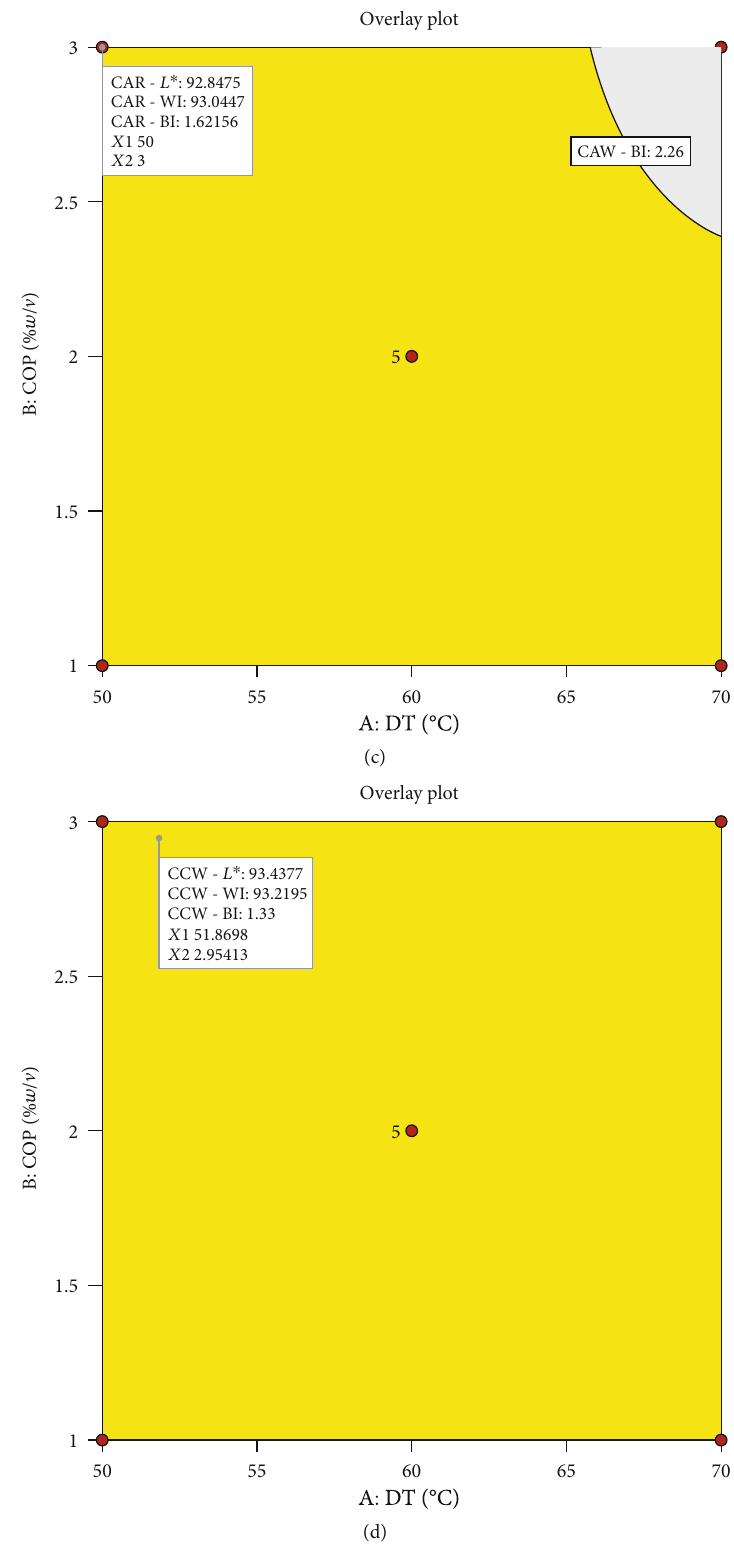
Figure 7: Multiresponse optimisation overlay plots for optimisation of processing conditions and colour properties of cassava fl our. (a) Cassava from red landrace pretreated with citric acid. (b) Cassava from red landrace pretreated with calcium chloride. (c) Cassava from white landrace pretreated with citric acid. (d) Cassava from white landrace pretreated with calcium chloride. DT — drying temperature ( ° C); COP — concentration of pretreatment (% w / v